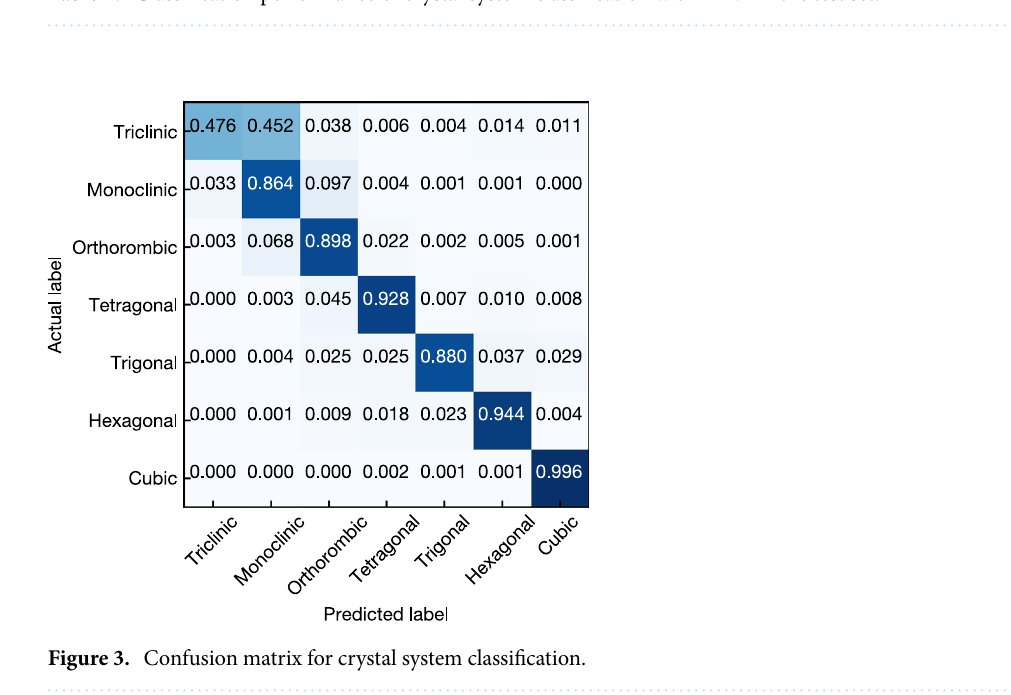
Table 2. Classification performance of crystal system classification with ExRT in the test set.